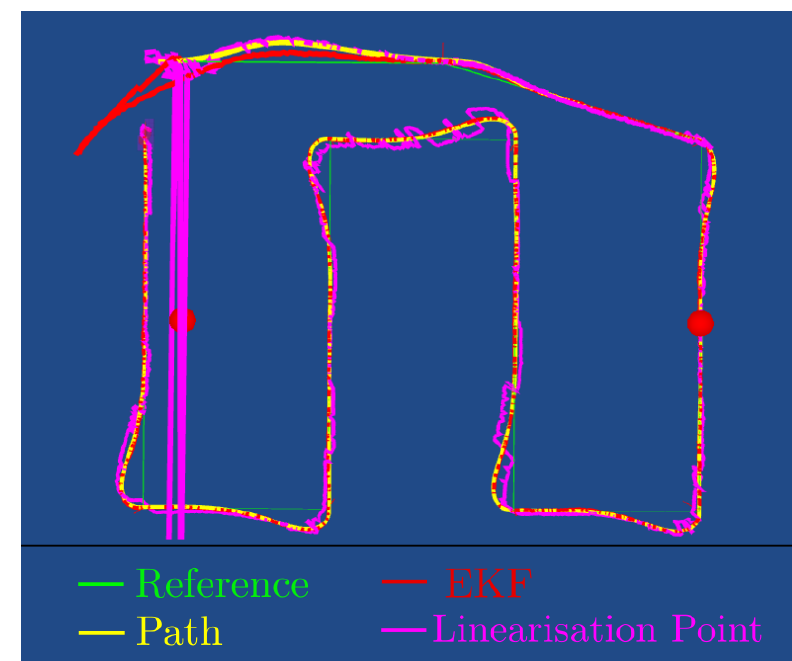
Figure 6. Scenario 1 with modified extended Kalman filter.